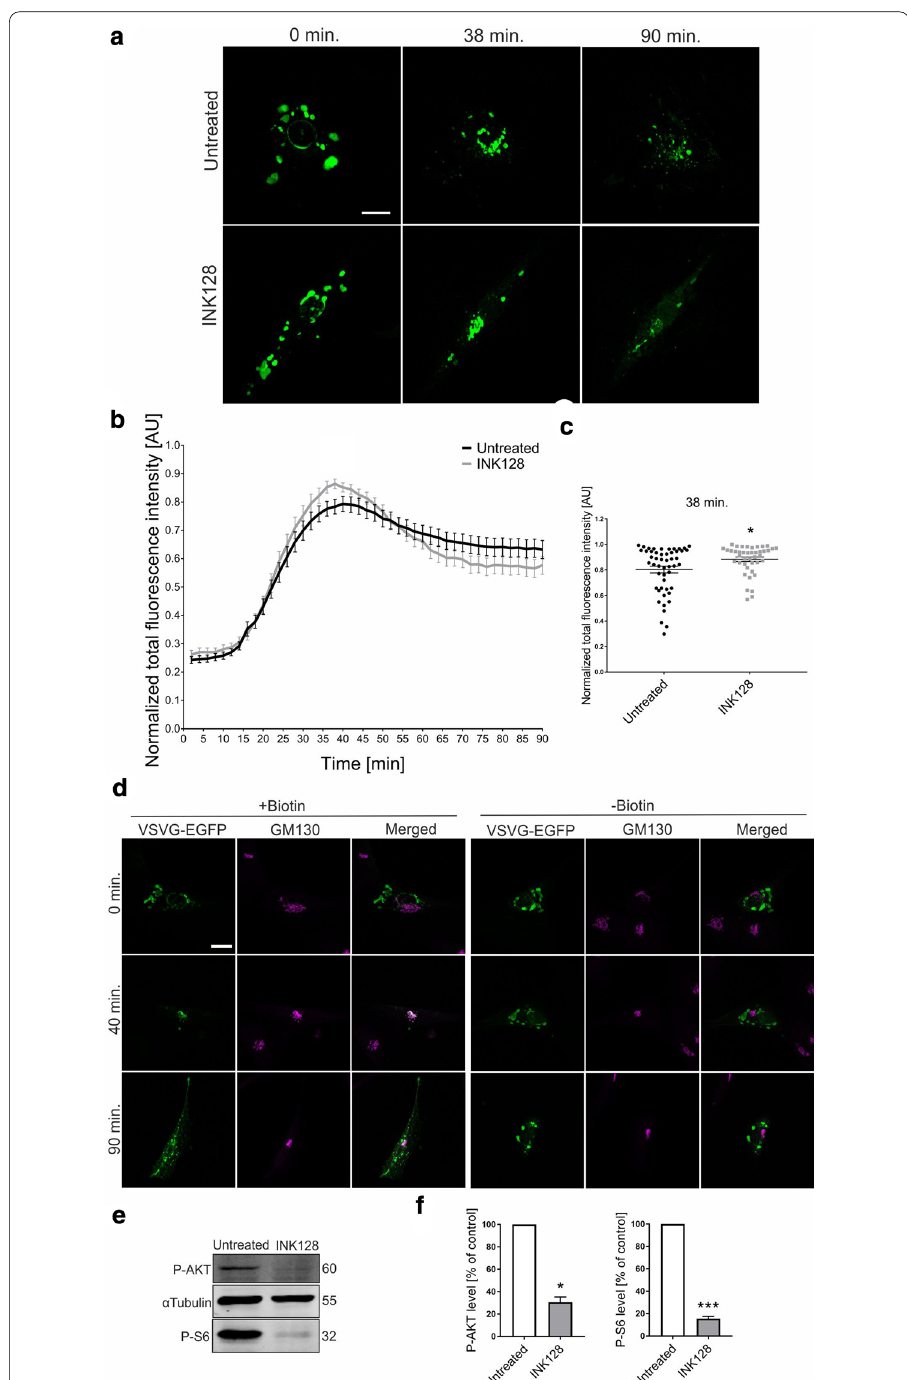
S11, Additional file 13: Movie S12). Fibroblasts that were derived from a healthy person served as a control. In cells with the TSC1 mutation, the level of TSC1 was substantially lower, and levels of P-S6 and P-Akt changed accordingly (Fig.